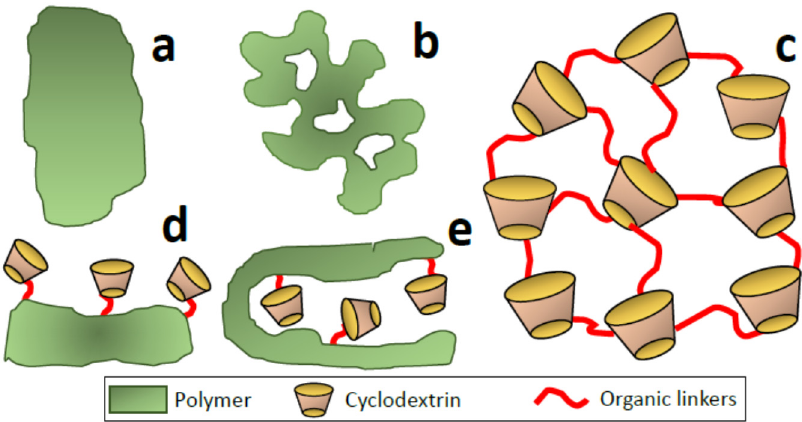
Figure 3. Schematic representation of the structures of ( a ) a non-porous polymer, ( b ) a porous polymer, ( c ) nanosponge, ( d ) CD-functionalized non-porous polymer, and ( e ) CD-functionalized porous polymer.